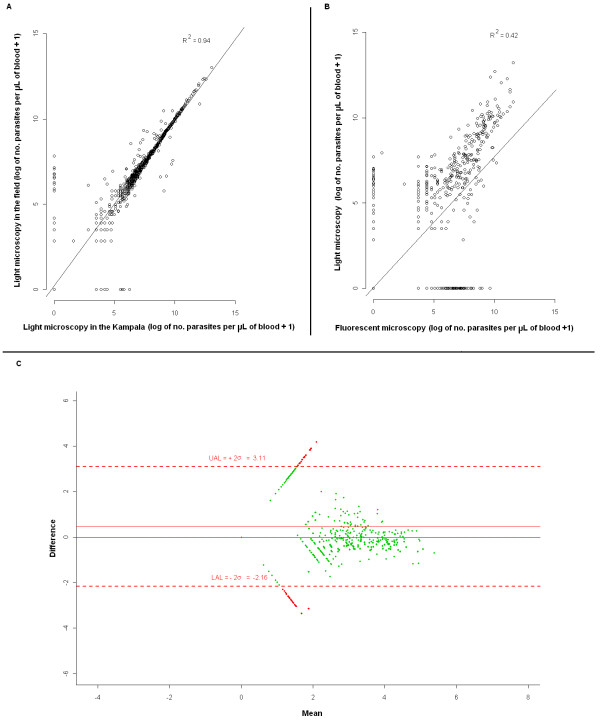
Graphical representation of correlation between: A) Giemsa-stained slide reads using light microscopy in the field and in Kampala using Ministry of Health facilities and between B) slides read using fluorescent microscopy (CyScope®) and Giemsa-stained slide reads using light microscopy in the field. C) Bland-Altman difference plot comparing fluorescent and light microscopy in the field. The points are plotted with the difference between fluorescent and light microscopy on the y-axis, and the mean of the two observations on the x-axis. The confidence bounds are plotted as dotted red lines, and all points within the confidence bounds are coloured green, all points outside the confidence bounds in red. The region of agreement is the area within the confidence bounds. The black solid line is the "difference = zero line" and the red solid line indicates the "average difference".